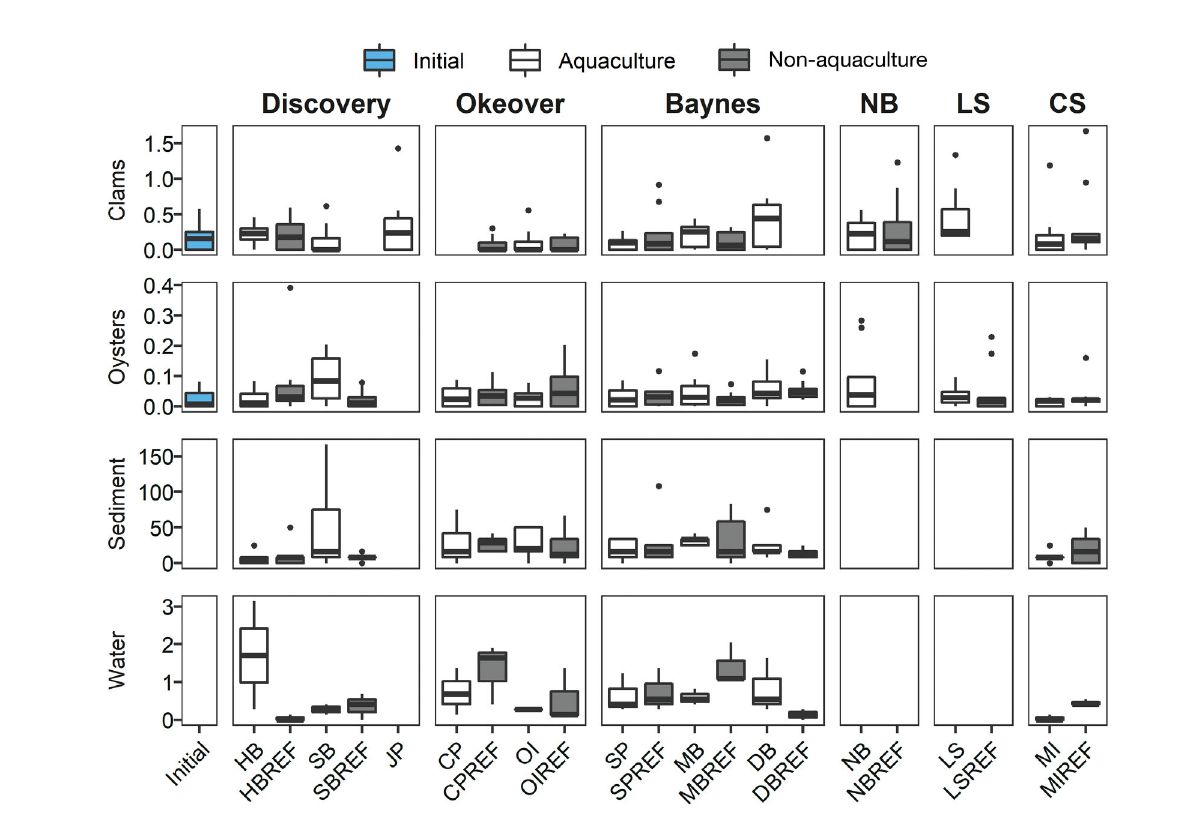
Fig. 5. Boxplots of microplastic particle (MP) concentrations in Manila clams Venerupis philippinarum (MP g −1 dry-tissue weight), Pacific oysters Crassostrea gigas (MP g −1 dry-tissue weight), sediment samples (MP l −1 ), and seawater samples (MP l −1 ) taken at shellfish aquaculture and non-aquaculture sites. The ‘initial’ concentrations represent oysters and clams that were sampled before they were out-planted to the various study sites. All concentrations are adjusted for identification error and for background contamination. Box limits and whiskers show first and third quartiles, respectively, with outliers (more than 1.5 times the distance between the first and third quartiles away from the median) shown as points. Study region is indicated at the top, see Fig. 1 for site and region